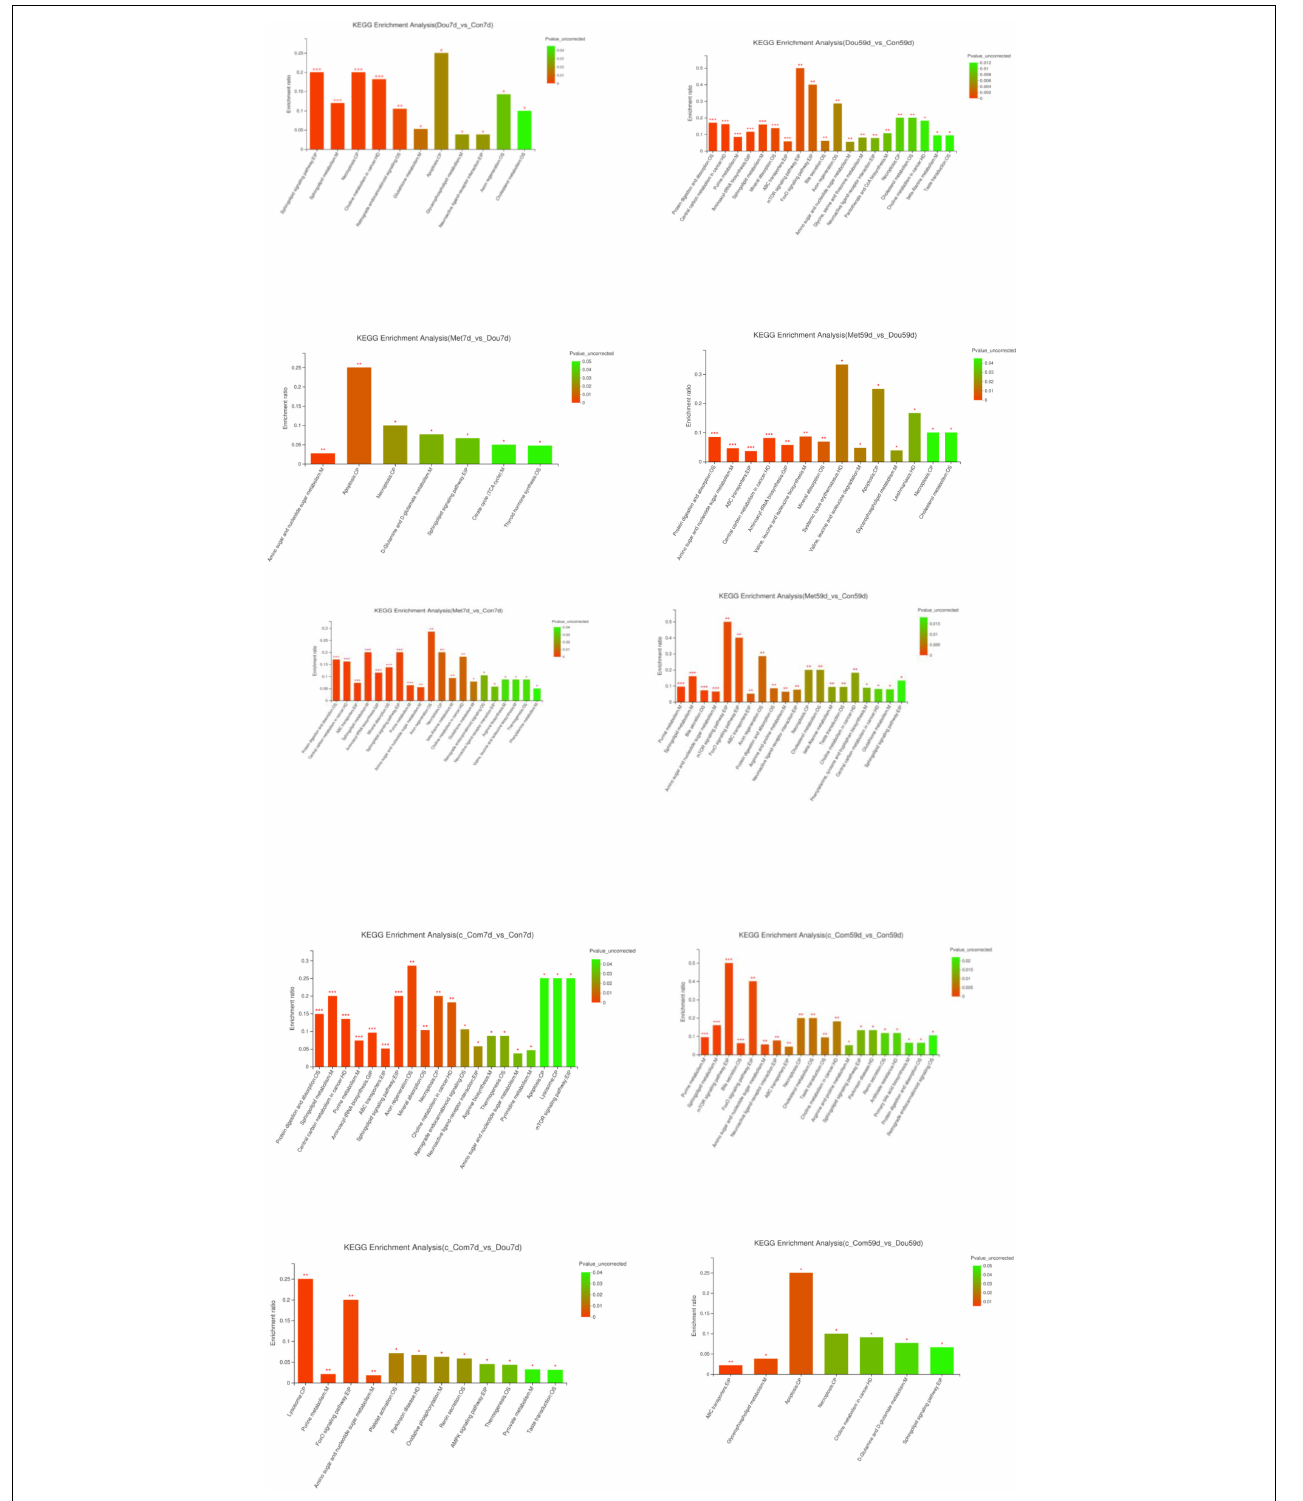
FIGURE 8 | KEGG enrichment analysis. The abscissa represents the pathway name, and the ordinate represents enrichment rate, representing the ratio between the Metabolite number enriched in this pathway, and the Background number annotated. The higher the ratio, the greater the degree of enrichment. The color gradient of the column represents the significance of enrichment. The darker the default color is, the more significant the enrichment of the KEGG term is. In particular, P -value < 0.001 is marked as ***, P -value < 0.01 is marked as **, and P -value < 0.05 is marked as *. The following table is the same.